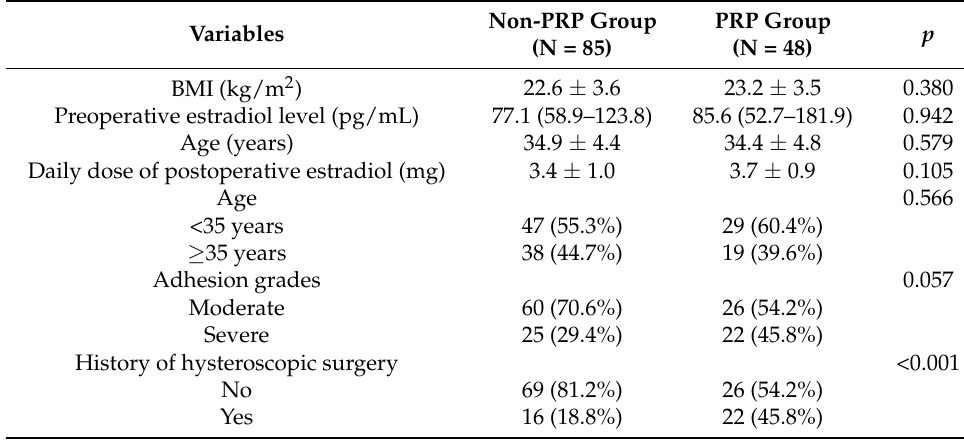
Table 2. Characteristics of the study